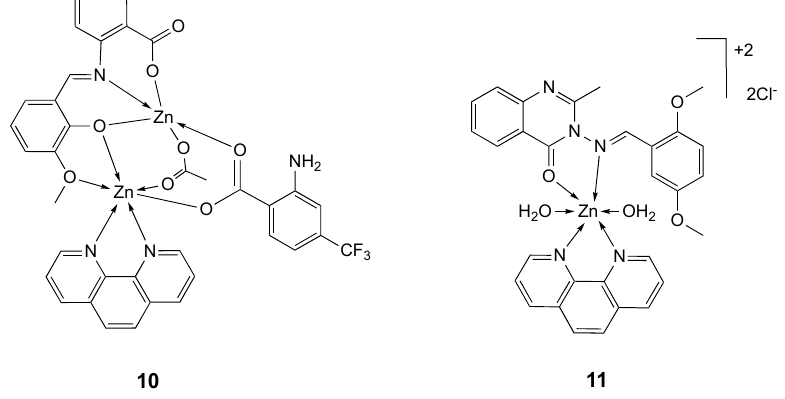
Figure 7. Structure of the zinc complexes 10 and 11 .